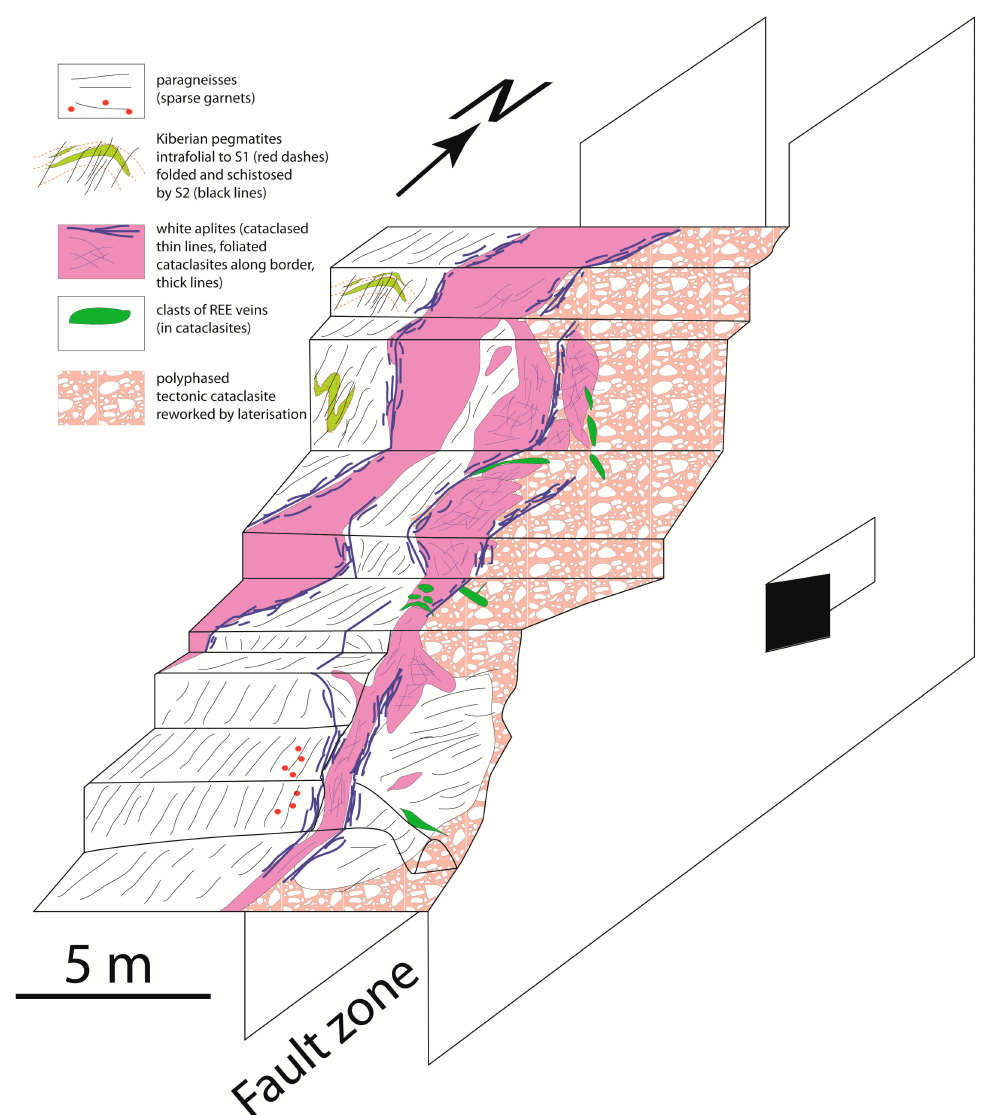
Figure 5. 3D synthetic block of the Kiyenzi trench n ◦